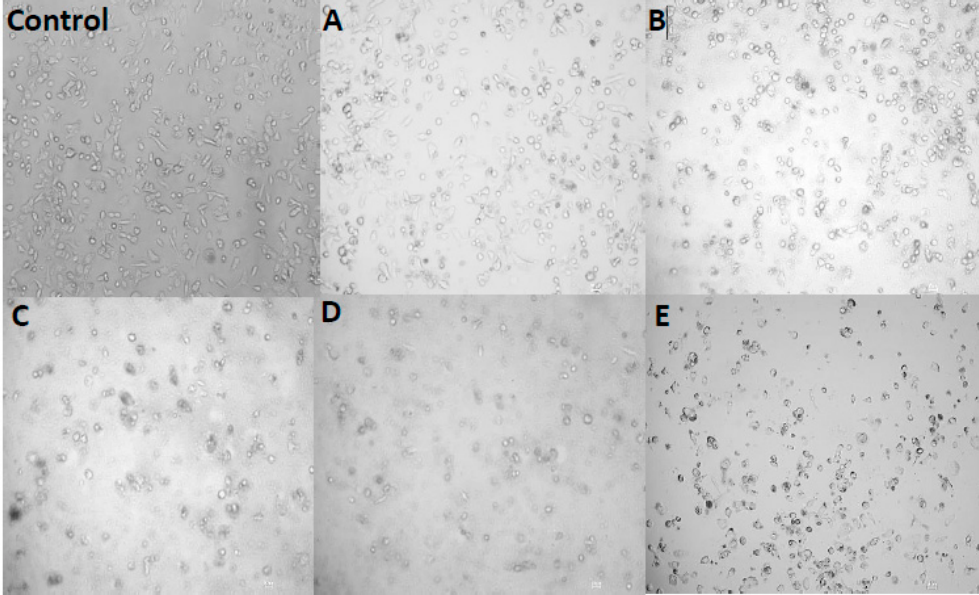
Figure 7. Cell morphology of Caco-2 cells treated with different concentrations of C3G nanoliposomes. The cells were treated with C3G nanoliposomes of different concentration (0 mg/mL ( Control ), 0.05 mg/mL ( A ); 0.10 mg/mL ( B ); 0.15 mg/mL ( C ); 0.20 mg/mL ( D ) and 0.25 mg/mL ( E )).